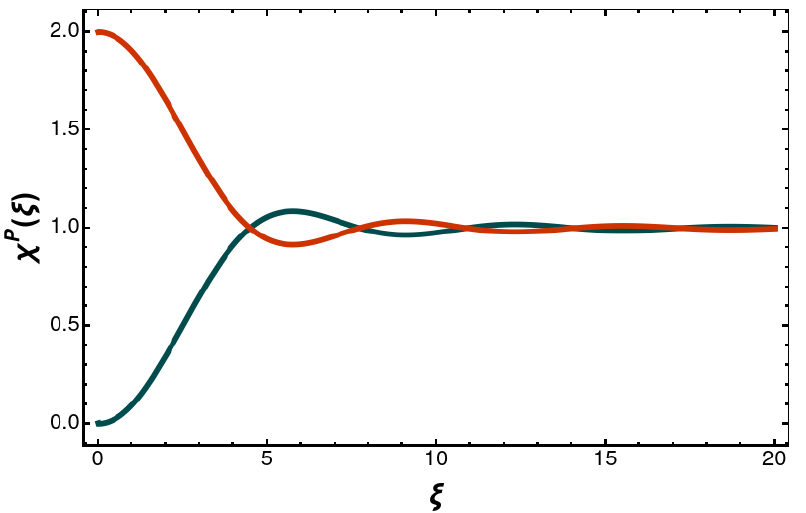
( ξ ) , where the red curve corresponds to the f ± (cid:107)